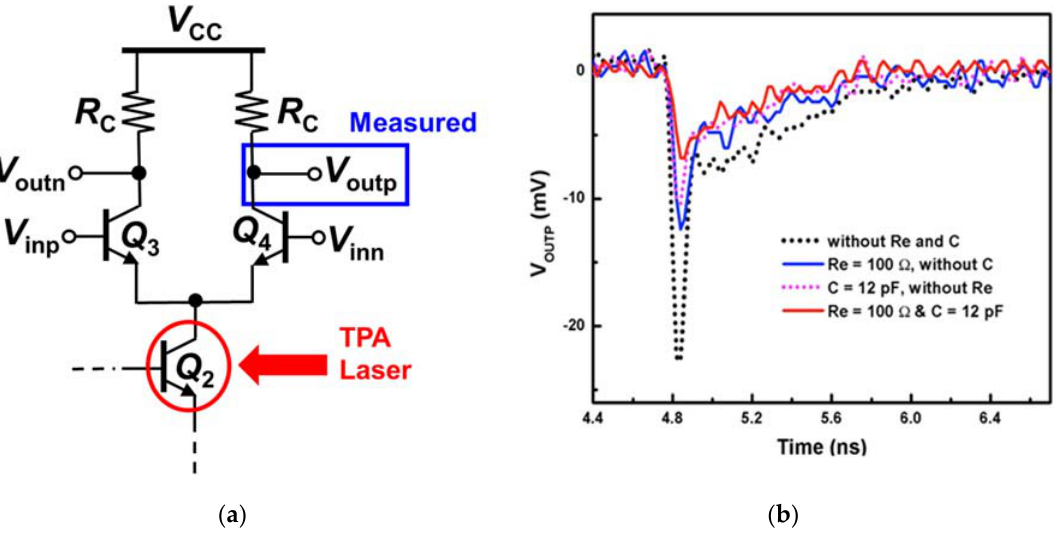
Figure 4. ( a ) The output transistor Q 2 of the DC current mirrors of all four CML circuits in Figure 2 was struck by the two ‐ photon ‐ absorption (TPA) laser; ( b ) Transient responses at the positive output terminal (Q 4 collector) of the differential pair was measured.